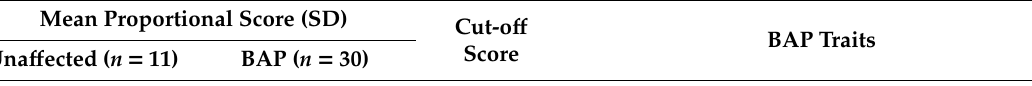
Table 2. Four endophenotypes of the BAP in the small families